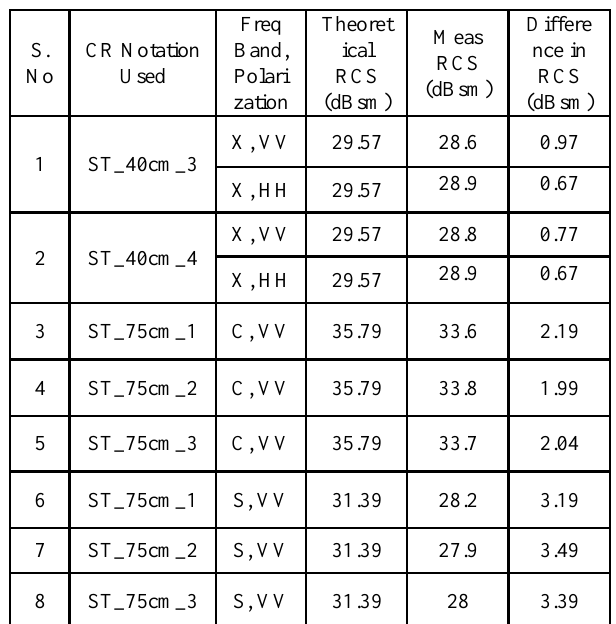
Figure 4(e): Plot of measured RCS values of ST_75cm_2in VV polarization at S-band (3.2GHz).